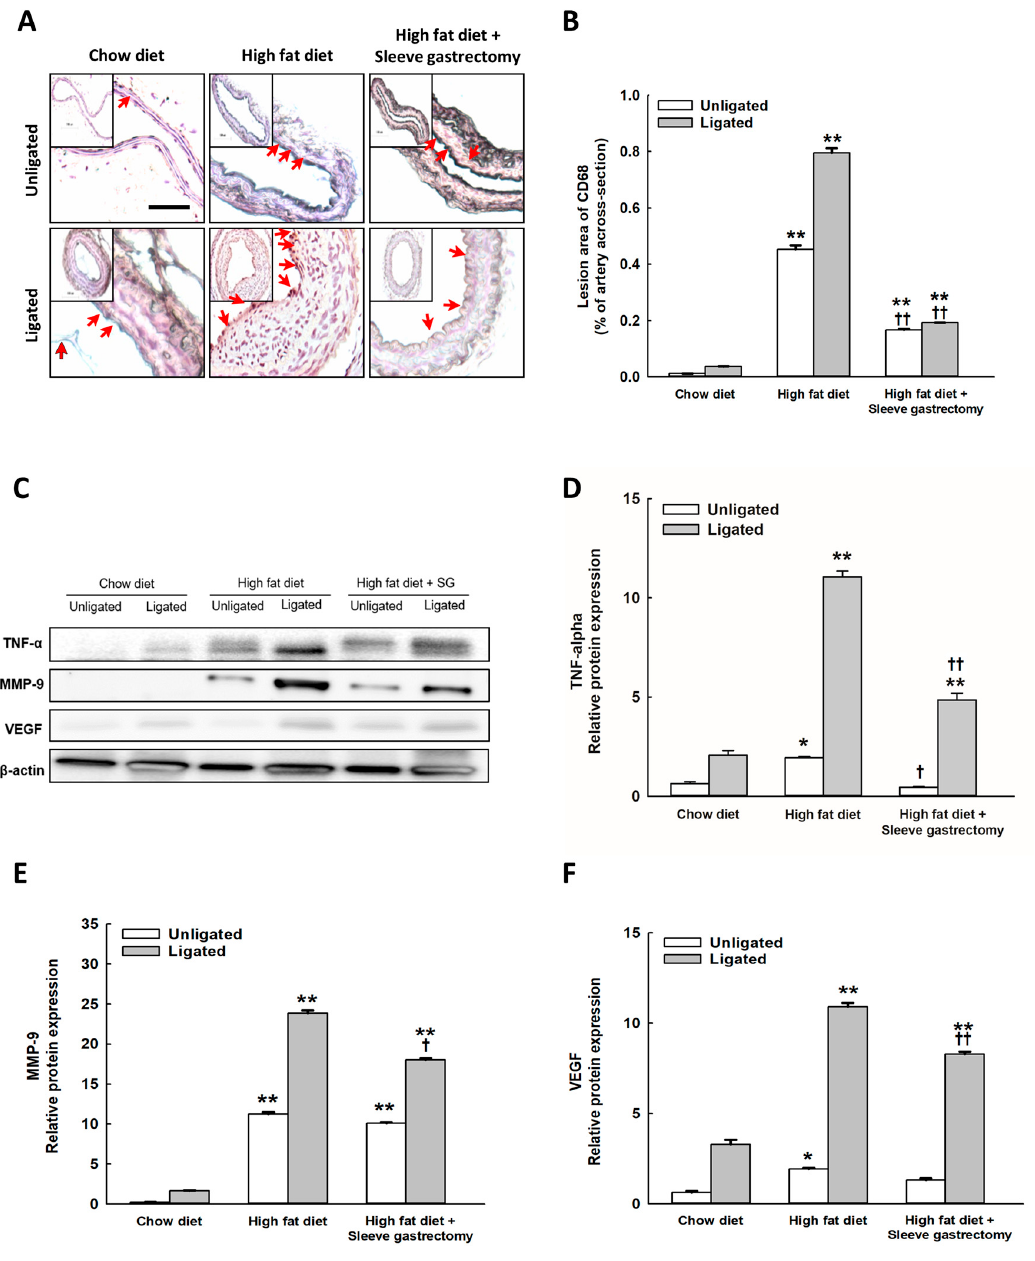
Figure 4. SG ameliorated HFD induced inflammatory reaction and protein expression in the ligated carotid artery. Representative light micrographs from the ligated left common carotid artery of the